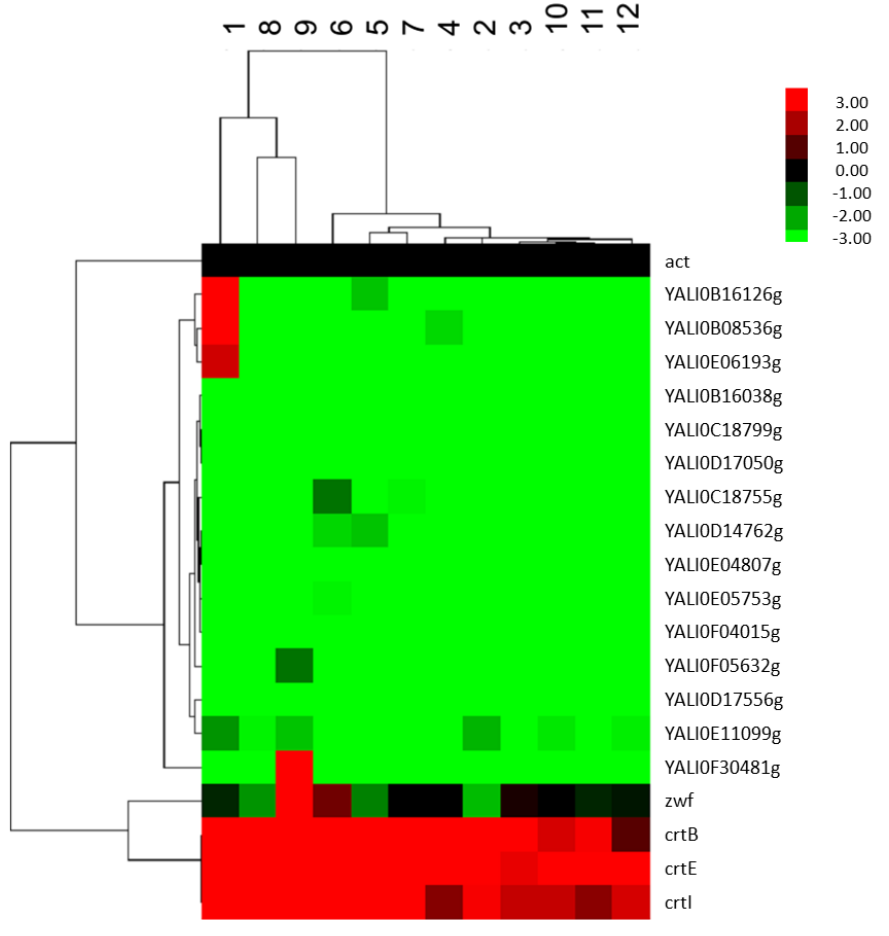
Figure 1. Heat map showing the expression levels of crtE, crtB, crtI, zwf , and terpenoids backbone genes in Po1f-1312E + 1269IB with respect to that of the internal control ACT1 average of three independently grown